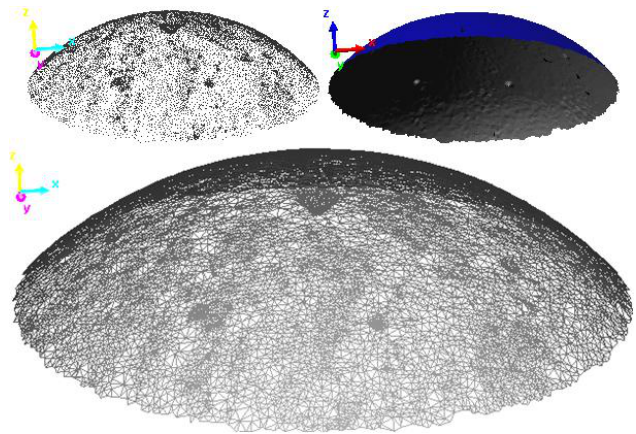
Figure 12. The point cloud ( top - left ), solid ( top - right ), and mesh ( below ) visualization of Semahane’s dome.